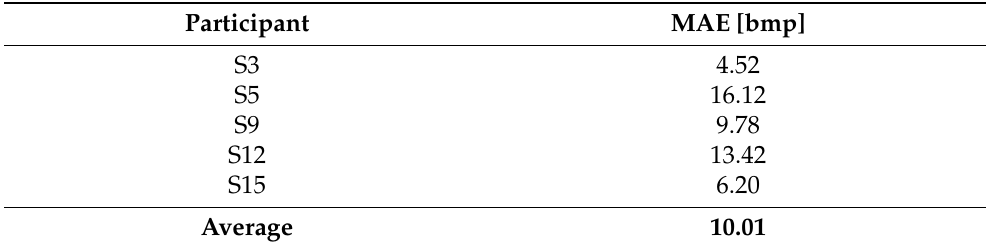
Table 9. Metric scores for frequency domain data, MAE (bpm).